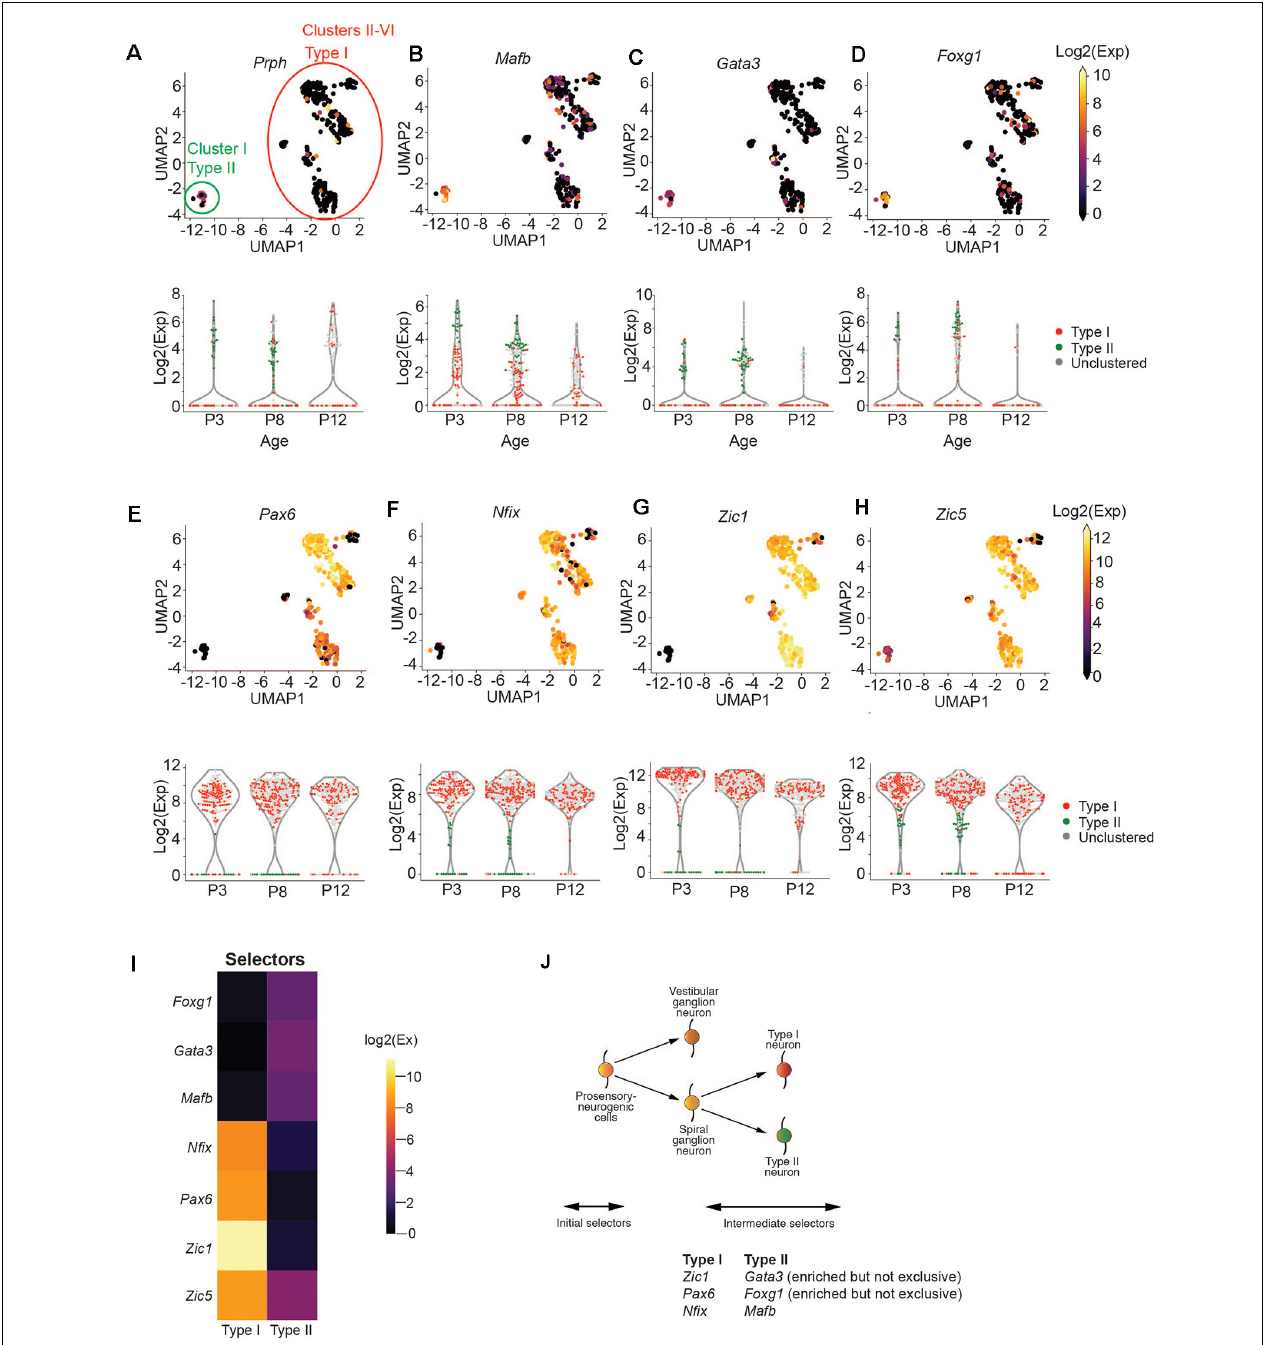
FIGURE 2 | Zic1, Zic5, Pax6 , and Nfix are Type I SGN markers. (A–D) UMAP projection of all SGNs from postnatal day 8 cochlea ( n = 383 cells, pooled from 7 technical runs representing 28 animals). Each point represents a single cell. Type I and Type II cells are circled in red and green, respectively. Cells are colored by the expression of Prph (A) , Mafb (B) , Gata3 (C) , and Foxg1 (D) . The expression scale is given on the right. Violin plots for each gene are given below the UMAP plot. Each point represents a cell. Cells are colored either red (Type I), green (Type II), or gray (unclustered). (E–H) UMAP projections and violin plots as in (a) for Pax6 (E) , Nfix (F) , Zic1 (G) , and Zic5 (H) . (I) Heatmap for effector genes. (J) Proposed schematic for Type I and Type II specification based on data above.